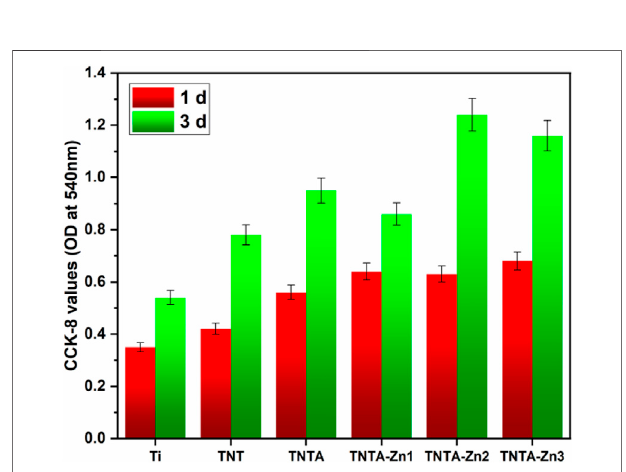
FIGURE8| Proliferationbehaviorsoftheendothelialcellsonthedifferent samples characterized by CCK-8.